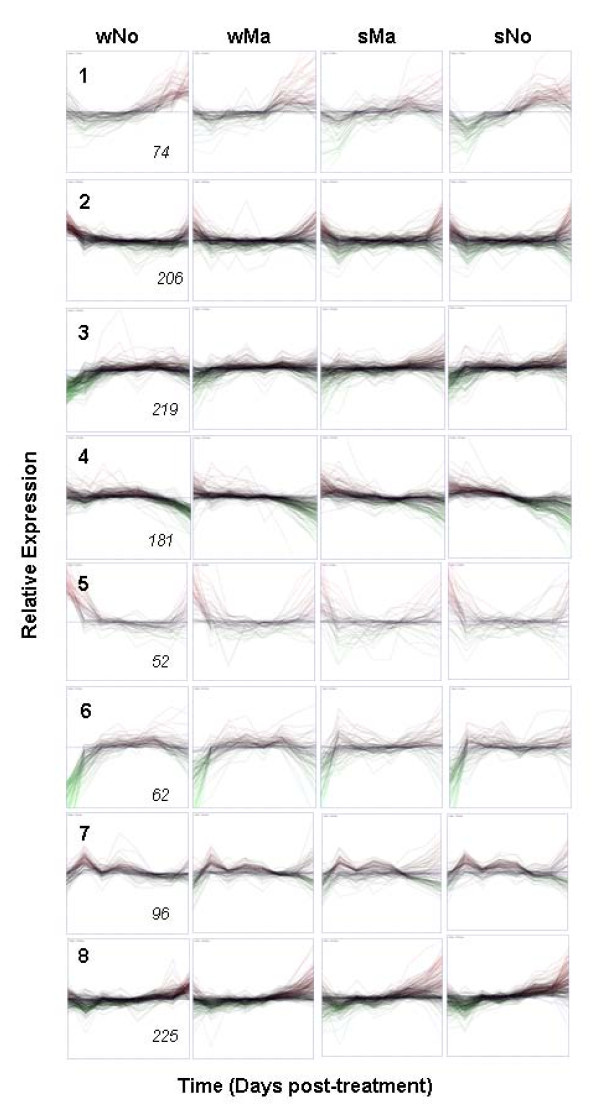
Clustering of expression profiles of genes that show 2-fold or more change in expression in Norstar and their comparative profiles in other genotypes. The x-axis in each frame represents duration of cold treatment from 0 to 70 days. The y-axis in each frame represents median centered relative gene expression in log 2. Relative expression was calculated by determining the difference between the maximum and minimum level of expression in the time-series. Cluster ID is indicated by the number on the upper left corner of each frame. The number of genes in each cluster is indicated on the lower right corner of each frame.